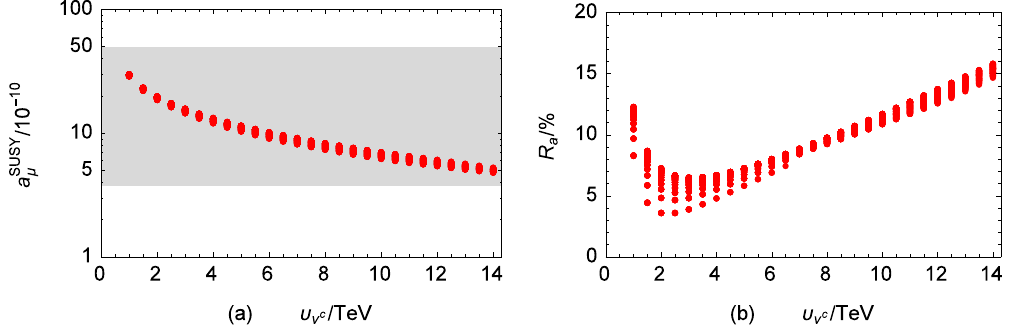
Figure 3 . a SUSY (a) and R a (b) vary with v (cid:23) c , where the gray area denotes the muon MDM (cid:22) at 3 : 0 (cid:27) .